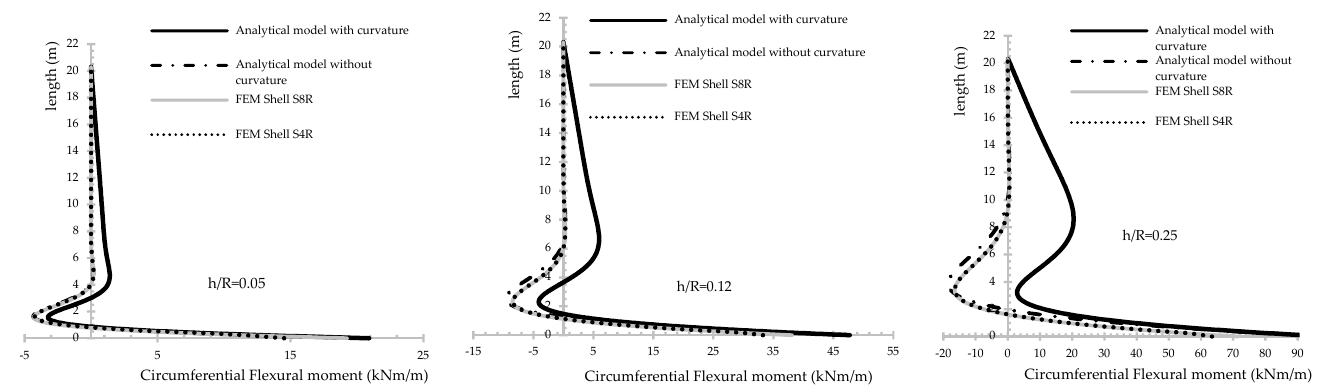
Figure 12. Longitudinal flexural moment for thin, medium and thick shells, considering different models.